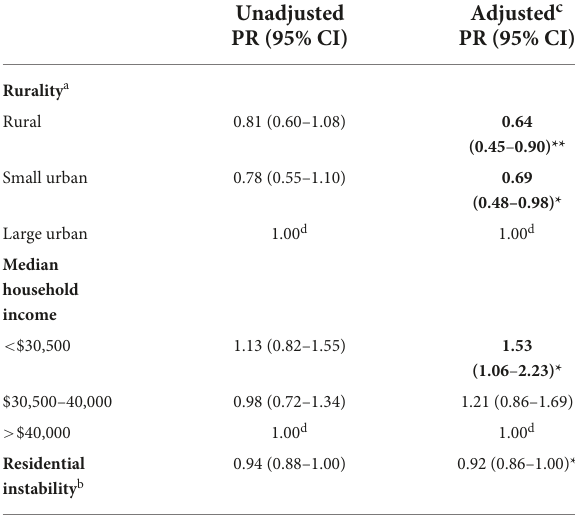
TABLE 3 Prevalence ratios of total neuropsychiatric symptoms by neighborhood characteristics, 2010 ( n = 212).